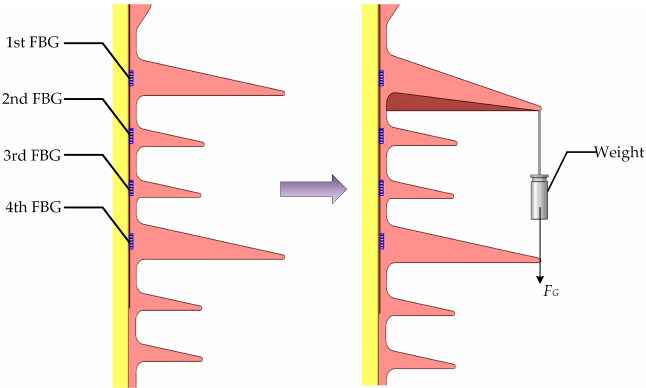
Figure 5. The experiment diagram of hanging a weight on an insulator shed for simulating glaze icing load. icing Table 4. Simulating the glaze icing load generated by an icicle with typical geometry [40]. Corresponding to the Icicle Corresponding to the Icicle Bridged Degree Weights Length L η